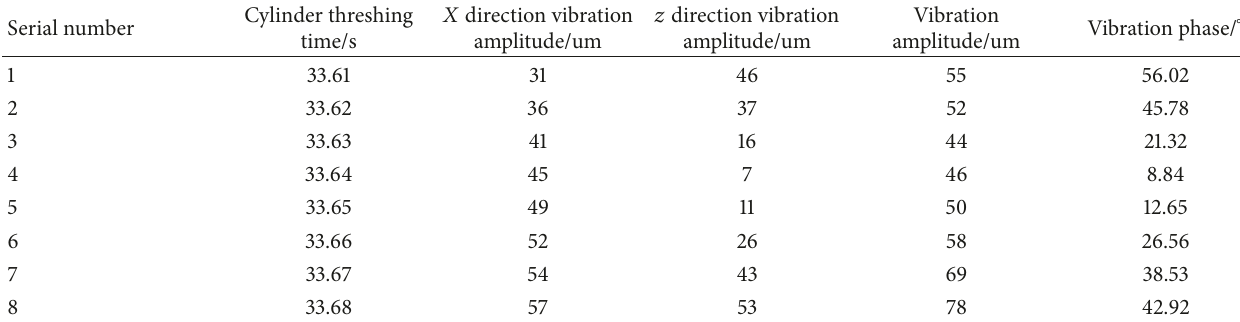
Table 3: 𝑋 and 𝑍 direction vibration values of small vibration on up and down